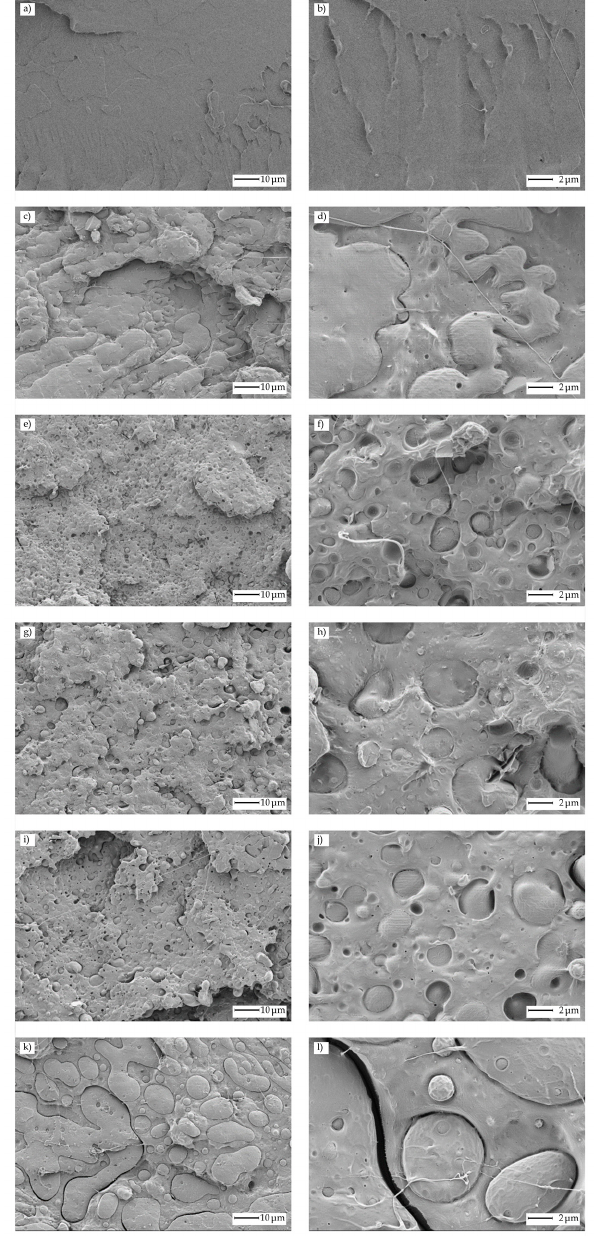
Figure 3. Field emission scanning electron microscopy (FESEM) images of fractured samples from impact test at 1000× (left column) and 5000× (right column) corresponding to PLA/PHB/PCL ternary blends (wt % PLA/wt % PHB/wt % PCL) ( a , b ) (100/0/0); ( c , d ) (60/40/0); ( e , f ) (60/30/10); ( g , h ) (60/20/20); ( i , j ) (60/10/30); and ( k , l ) (60/0/40). The scale bar for left images represents 10 µm while the scale bar for right images stands for 2 µm.